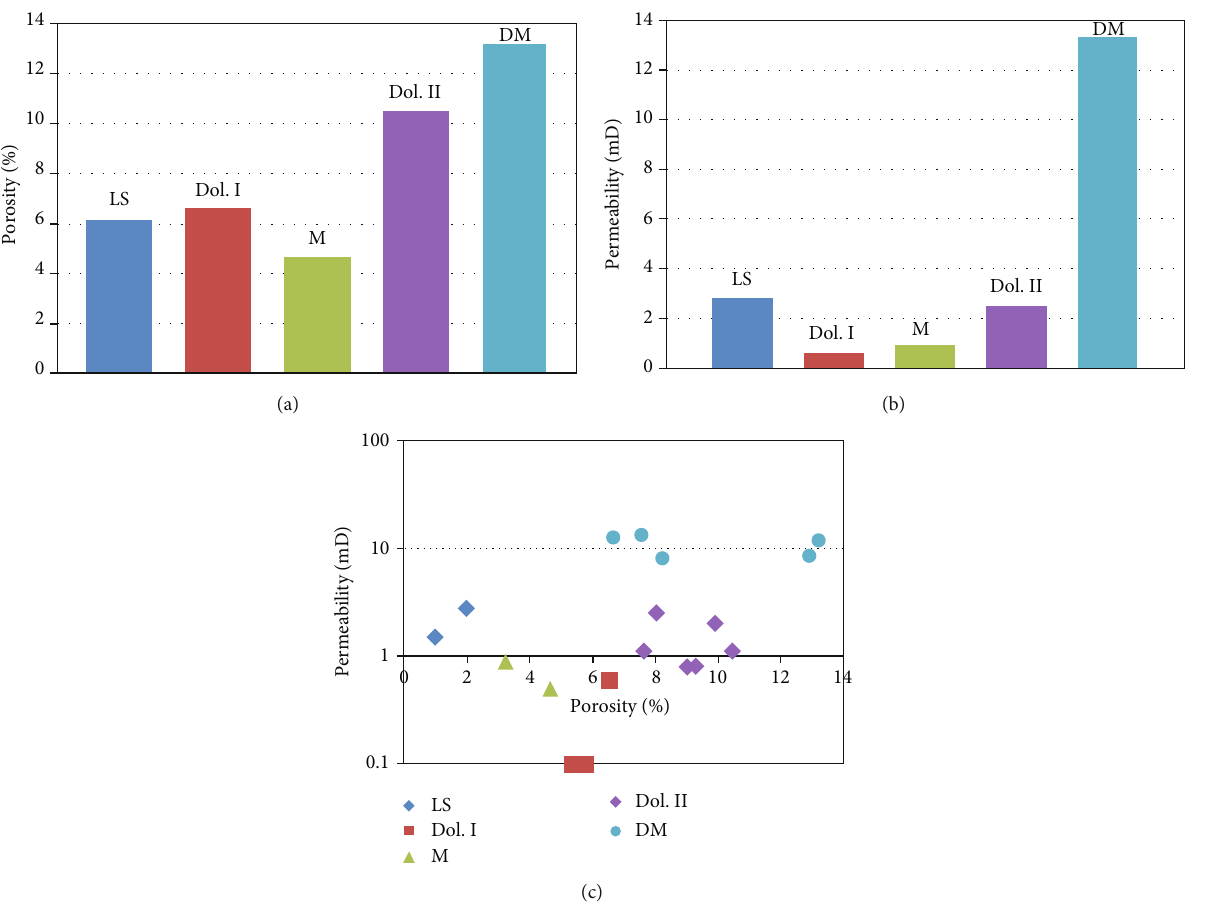
Figure 10: (a, b) Histograms showing porosity and permeability values of various diagenetic phases observed in Khyber Limestone. (c) Cross- plot showing porosity-permeability variation with respect to di ff erent diagenetic